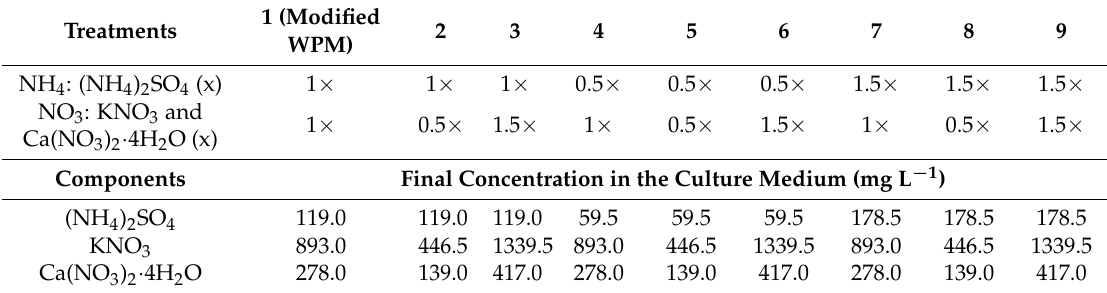
Table 2. Experiment 2 with treatments 1 to 9 on the modified Woody Plant Medium (WPM) [15] with different amounts of (NH 4 ) 2 SO 4 (x), KNO 3 , and Ca(NO 3 ) 2 · 4H 2 O (x).